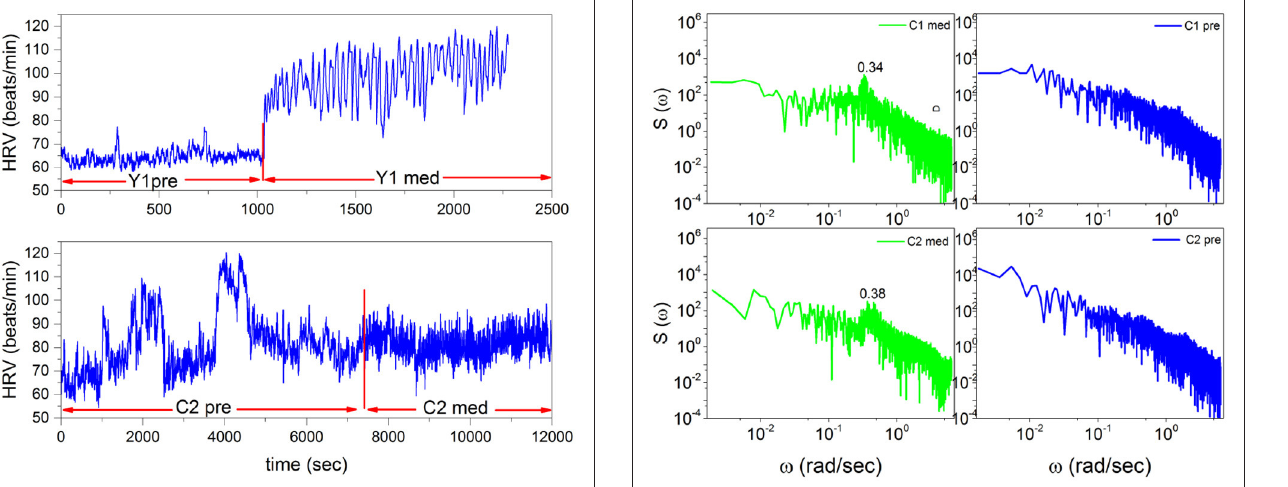
FIGURE 4 | HRV time series of Yoga meditator (Y1), at the top, and the Chi meditator (C2), at the bottom. The vertical red lines denote the time at which the two meditations start.